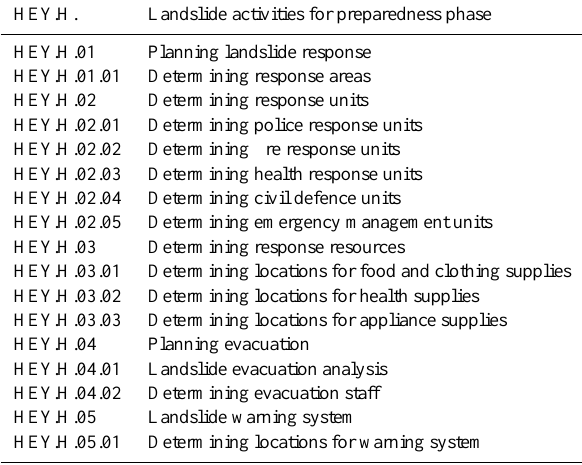
Table 2. Landslide activities for the preparedness